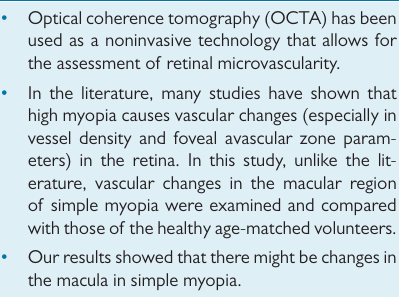
Figure 2. Superior and inferior ganglion cell complex